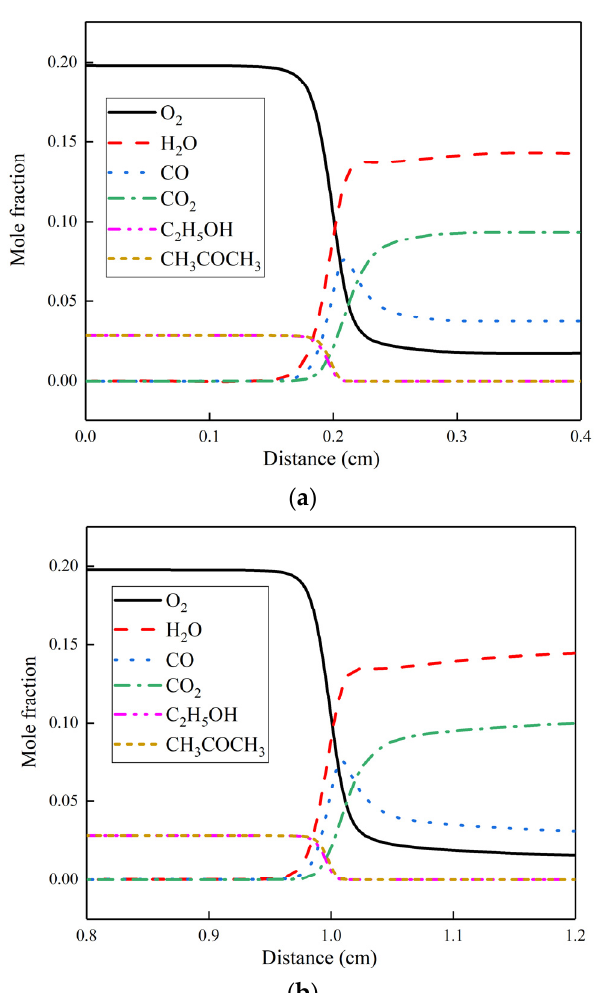
Figure 11. The flame structure at the equivalence ratio of 1.0 of ETAC11 (( a ) detailed mechanism, ( b ) skeletal mechanism).